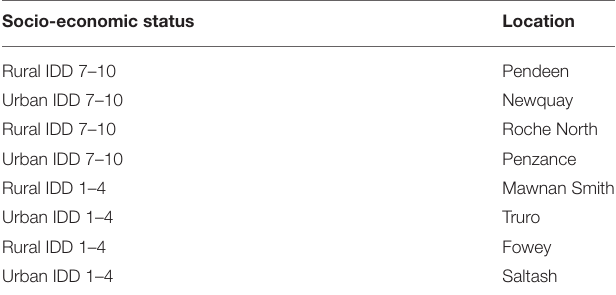
TABLE 1 | Focus group locations and